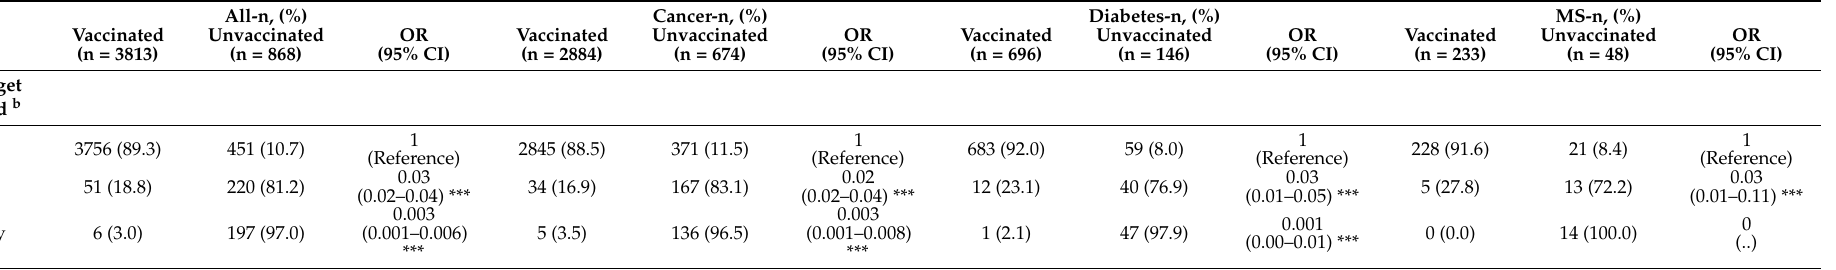
Table 2. Predicting vaccinated status a with vaccination intent, belief about contracting COVID-19, and the scale indices’